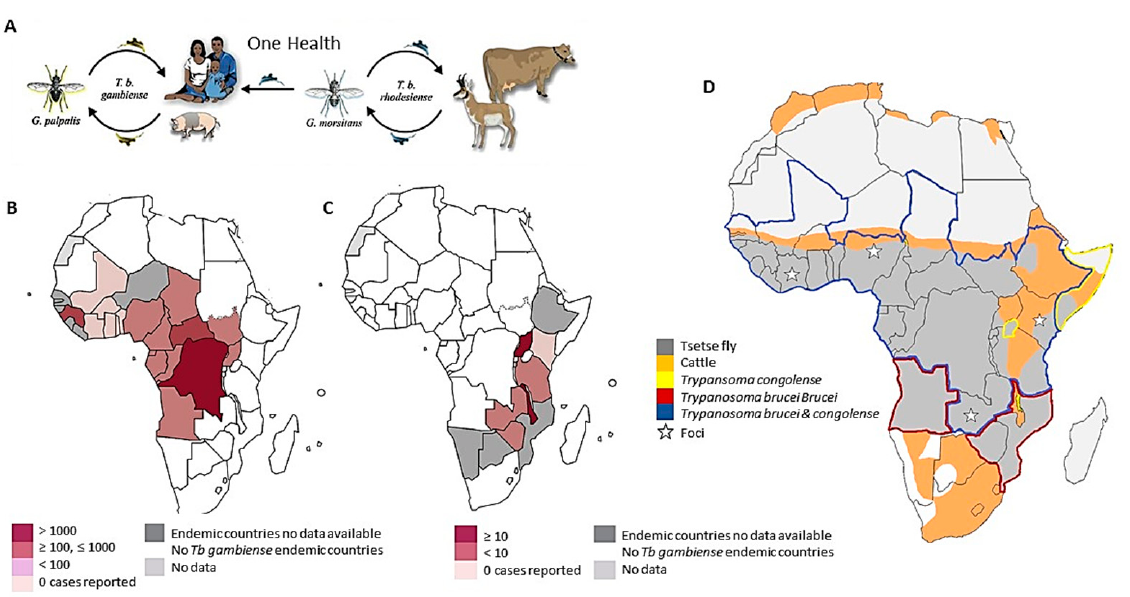
Figure 1. The transmission cycle and distribution of HAT ( A ) caused by T. b. gambiense has humans and domestic animals, especially pigs, as the main hosts. It is transmitted by the tsetse flies ( Glossina sp.) of G. palpalis group and is distributed in Western and Central Africa ( A , B ). HAT caused by T. b. rhodesiense has wild animals and cattle as the main hosts. It is transmitted by G. morsitans and is distributed in Eastern and Southern Africa ( A , C ) [1]. ( D ). The map shows the distribution of the tsetse fly and cattle, AAT caused by T. congolense, and HAT caused by T. b. brucei . Each area of interest is within a colored line or with colored content as reported in the legend. The transmission between humans and animals causes a One Health problem ( A , D ). (Figure 1A,B were adapted with permission from references [1]. Copyright year 2022, Elsevier under the license number